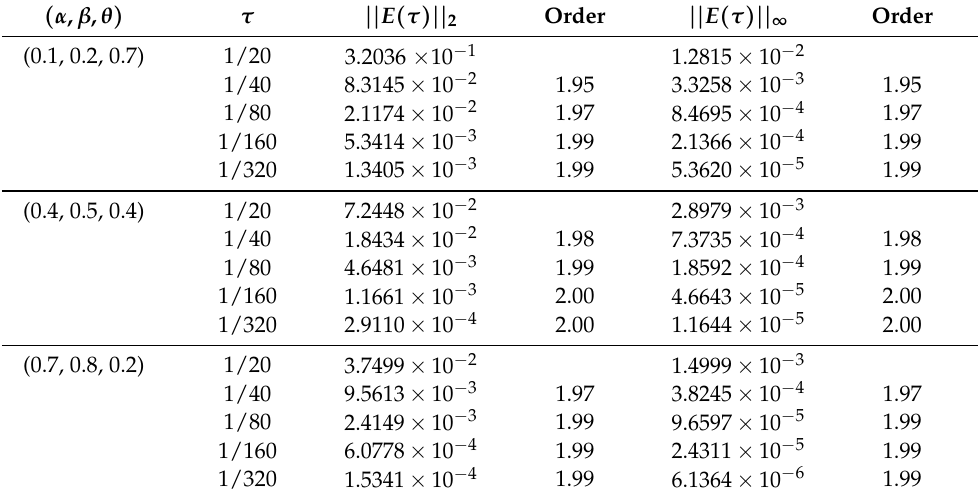
Table 2. Errors and spatial convergence orders with τ = 1